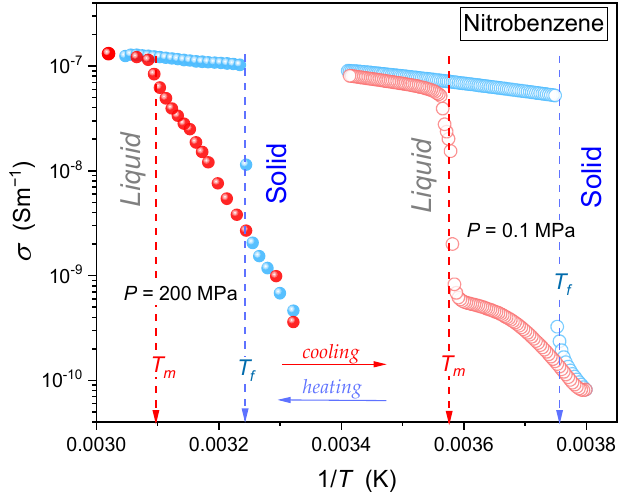
Figure 5. The Arrhenius-scale plot of DC electric conductivity in nitrobenzene on cooling from the liquid phase, passing the freezing temperature T f (in light blue), and on heating from the solid phase, passing the melting temperature T m , under atmospheric pressure ( P = 0.1 MP, open circles), and P = 200 MPa (full circles).